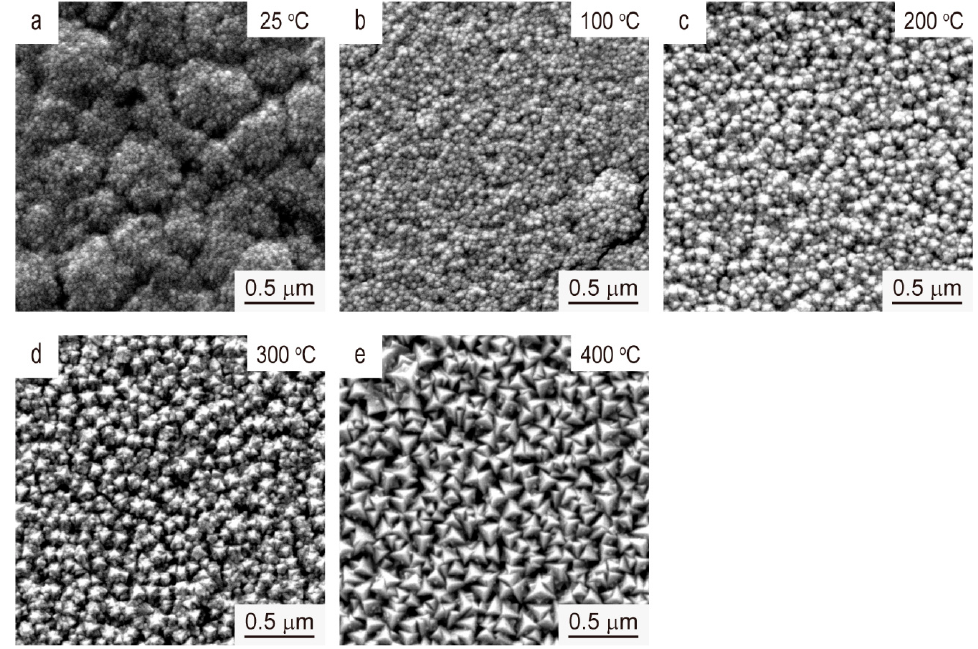
Figure 2. SEM images of the V films deposited on Si (100) at D t-s = 60 mm, T s = ( a ) 25 ◦ C, ( b ) 100 ◦ C, ( c ) 200 ◦ C, ( d ) 300 ◦ C, and ( e ) 400 ◦